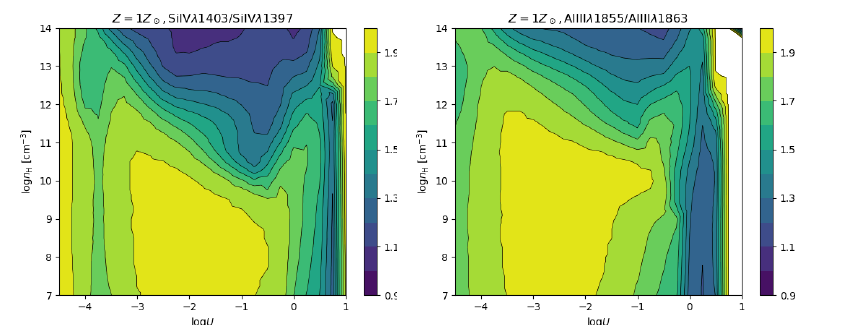
→ 2 S → 2 S )/I( 2 P o ) doublet components for Si IV (left panel) 1 1 3 1 2 2 2 2